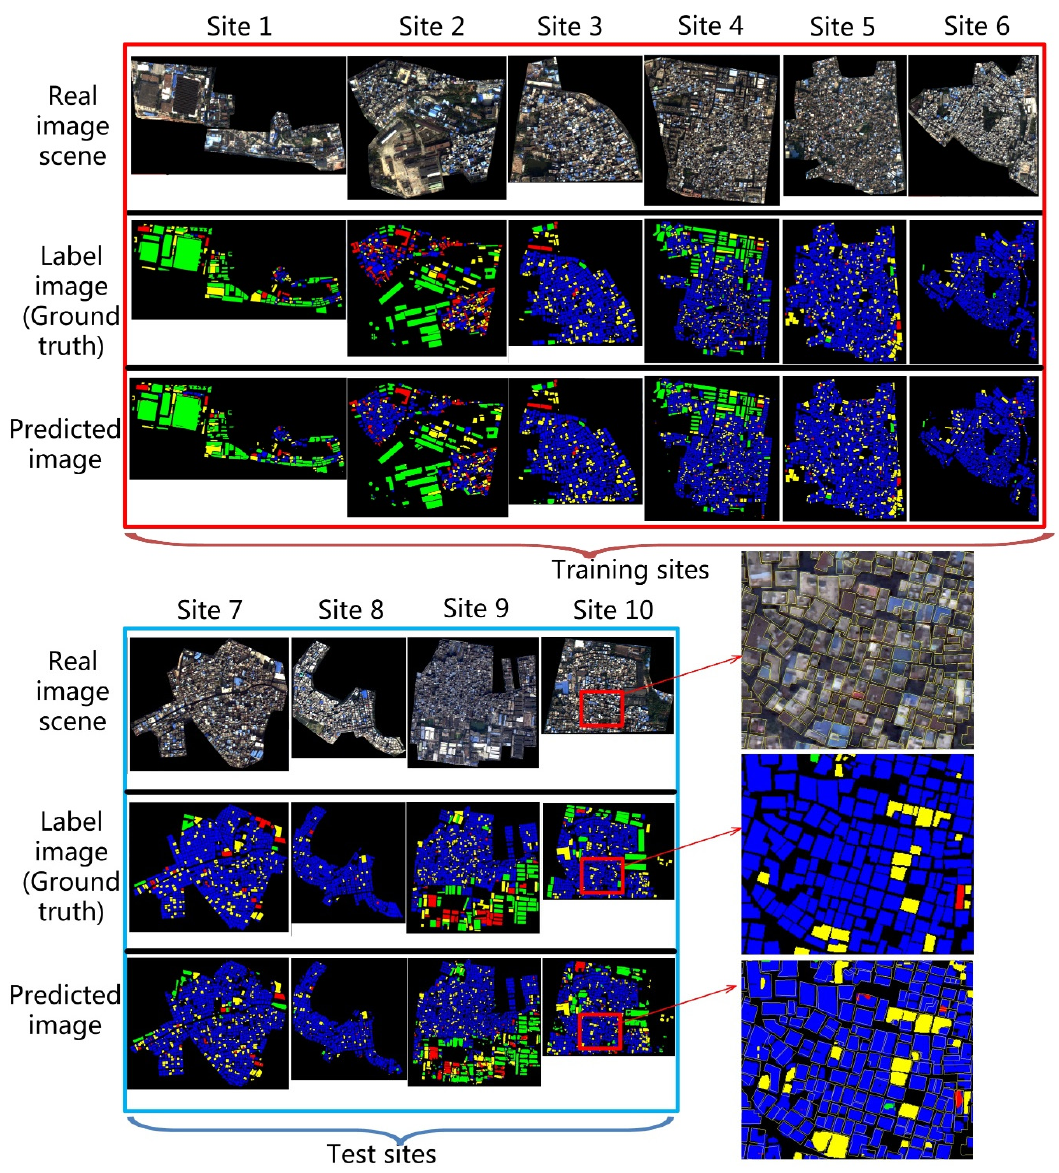
Figure 6. Performance of building classification by U-net (blue: Old house; green: Old factory; yellow: Iron roof building; red: New building).